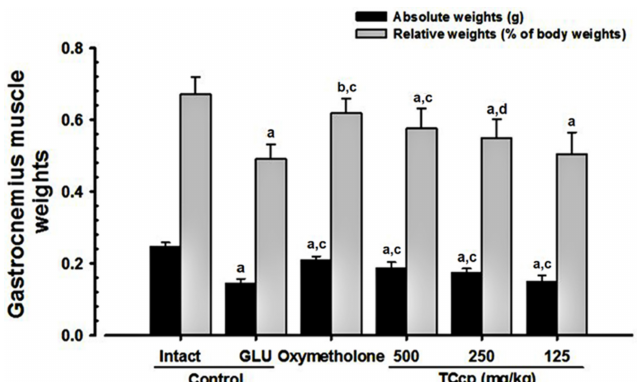
Figure 5. Variations in gastrocnemius muscle weights in GLU-induced muscular atrophic mice.Values are expressed means ± S.D. of eight mice. The gastrocnemius muscle mass weight was measured at day 24 of test material administration and expressed at g levels (absolute wet-weights) using automatic electronic balance. TCcp = tart cherry concentrated powder. GLU = glucocorticoid. DEXA = dexamethasone. Oxymetholone (50 mg/kg) dissolved in distilled water was orally adminis- tered. a p < 0.01 and b p < 0.05 as compared with intact control by LSD test. c p < 0.01 and d p < 0.05 as compared with GLU control by LSD